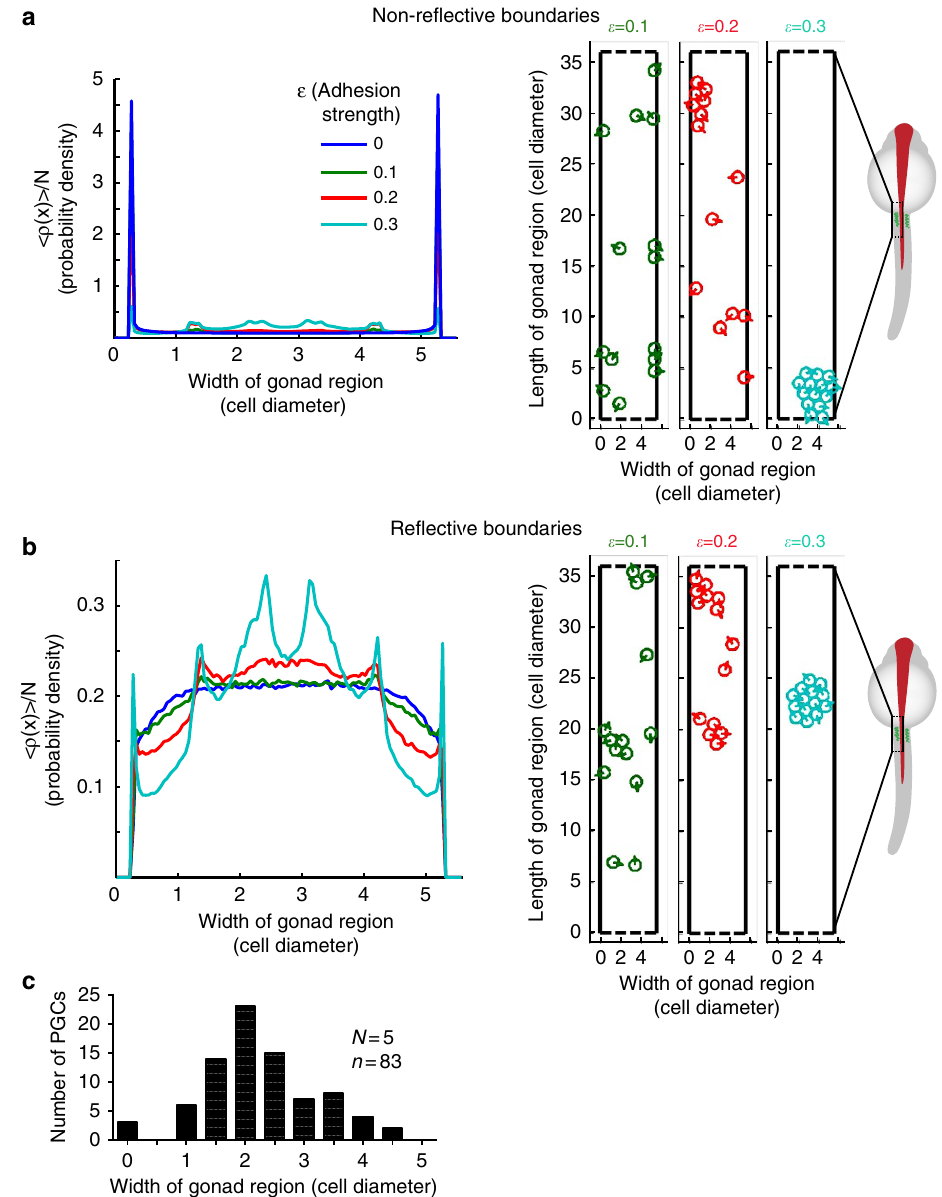
Figure 7 | Boundary conditions and cell–cell adhesion level control cell cluster size and positioning. The steady-state distribution of 14 particles across the gonad region (black box in the schematic zebrafish embryo; five cell diameter wide) that is confined by non-reflective ( a ) or reflective boundaries ( b ) for different cell–cell adhesion levels ( e ¼ 0–0.3 (a.u.)). The y axes in the graphs represent the probability density to find a given particle at a certain position at the site of gonad. Snapshots from Supplementary Movies 9–10 ( t ¼ 4850min) for different e values are provided on the right in a and b , respectively. ( c ) The distribution of cells at the gonad site in 24–25hpf zebrafish embryos. N is the number of embryos and n that of